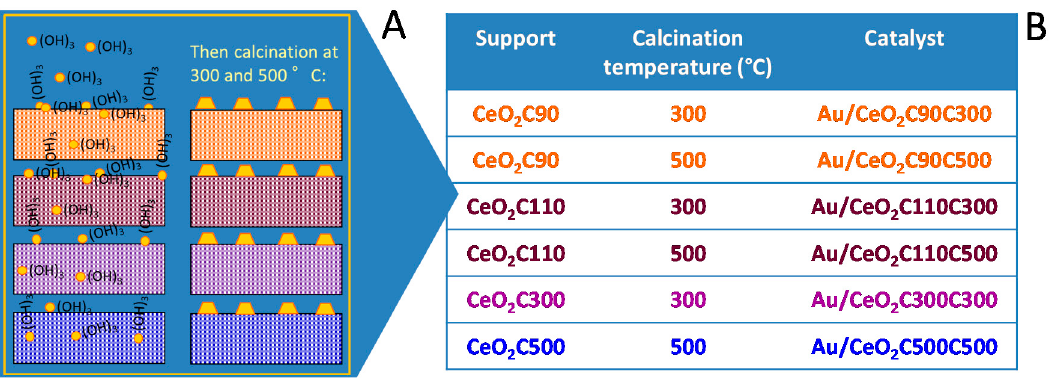
Figure 5. ( A ) Gold deposition–precipitation on the different CeO 2 supports; and ( B ) list of the obtained catalysts after subsequent calcination at 400 °C and 500 °C.